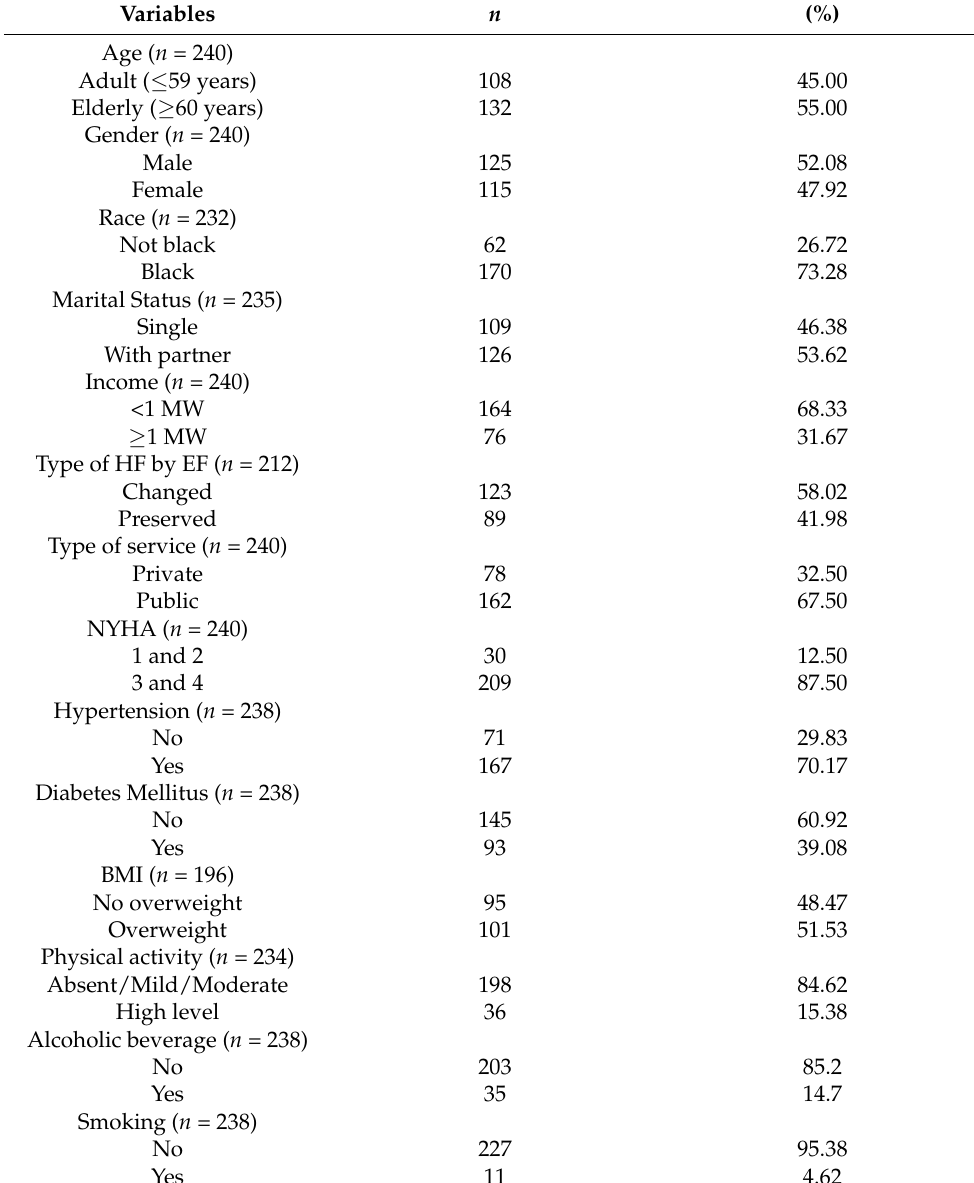
Table 2. Characterization of socio-demographic; clinical and lifestyle of patients hospitalized for decompensated HF in Aracaju, SE;